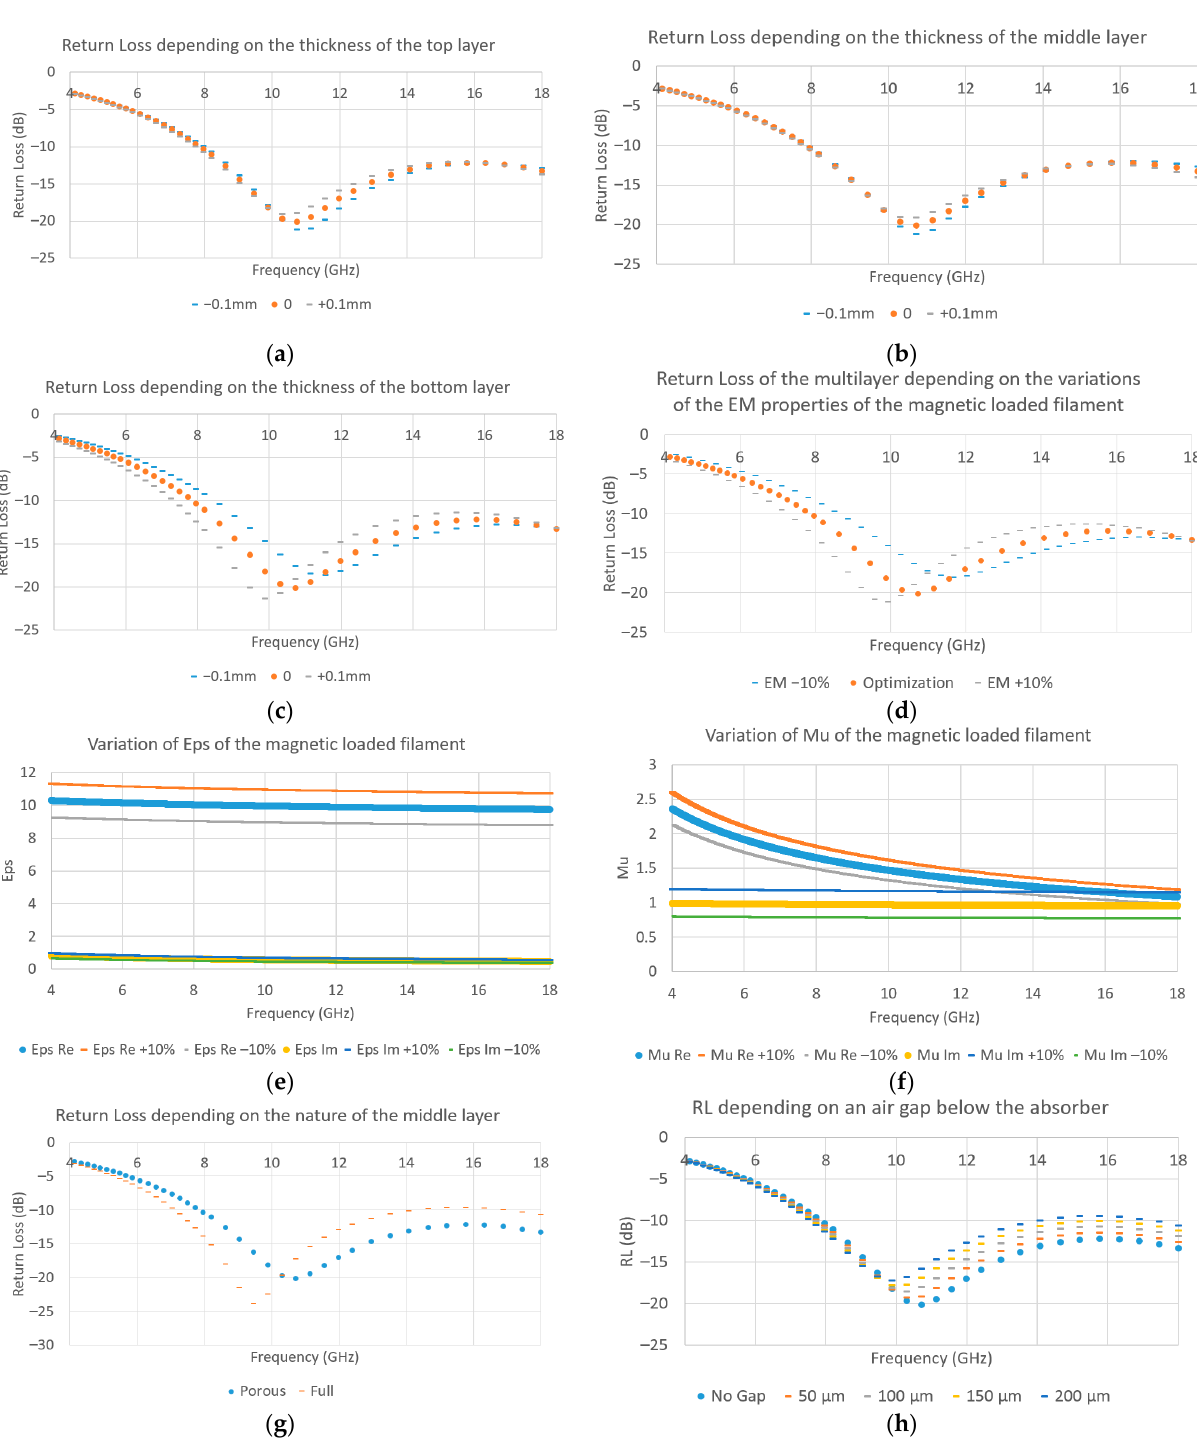
Figure 13. Parametric study of the thickness on the return loss (RL) at 10° of ( a ) the top layer, ( b ) the middle layer, ( c ) the bottom layer, ( d ) comparisons of simulations using different variations of EM properties of the magnetic-loaded material, variations of the EM properties of the magnetic loaded filament ( e ) of the permittivity Eps, ( f ) of the permeability Mu, ( g ) comparison of the reflectivity by modifying the nature of the middle layer, porous or full, ( h ) parametric study of an air gap under the absorber, 50 µm to 200 µm .